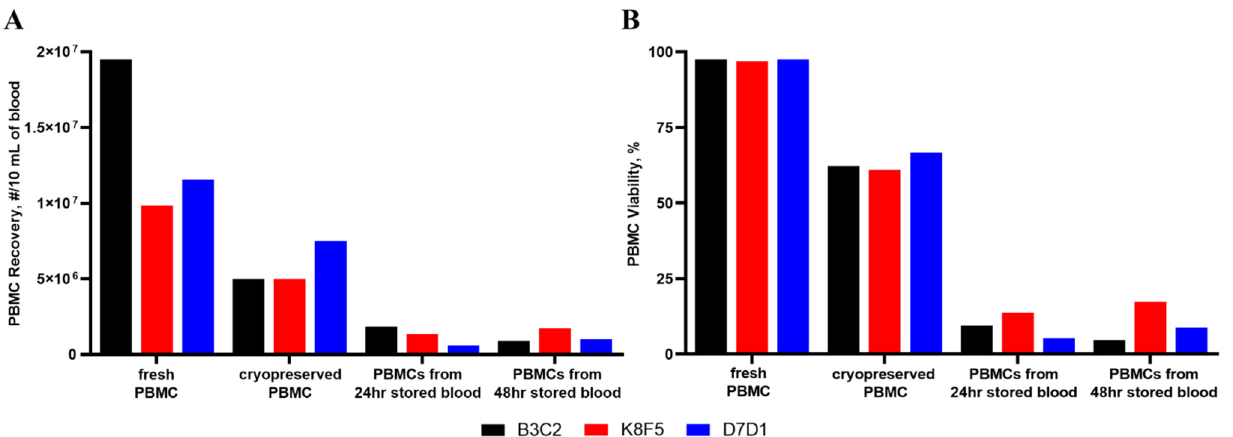
Figure 7. The Effect of Storage Conditions on PBMC Viability and Cell Recovery. To simulate various handling and storage conditions used in research, PBMCs from three healthy human donors were examined after fresh isolation, cryopreservation, and isolation from refrigerated blood (24 h or 48 h). Cell viability was then assessed using AO/PI. ( A ) Number of PBMCs recovered under the various storage/handling conditions. ( B ) Viability of stored PBMCs compared to their freshly isolated PBMC counterparts. Each bar shows the mean result and standard deviation (N = 3).